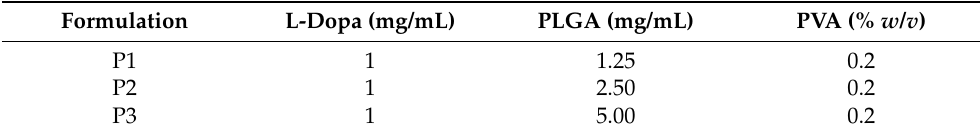
Table 1. Formulation composition of L-Dopa loaded PLGA